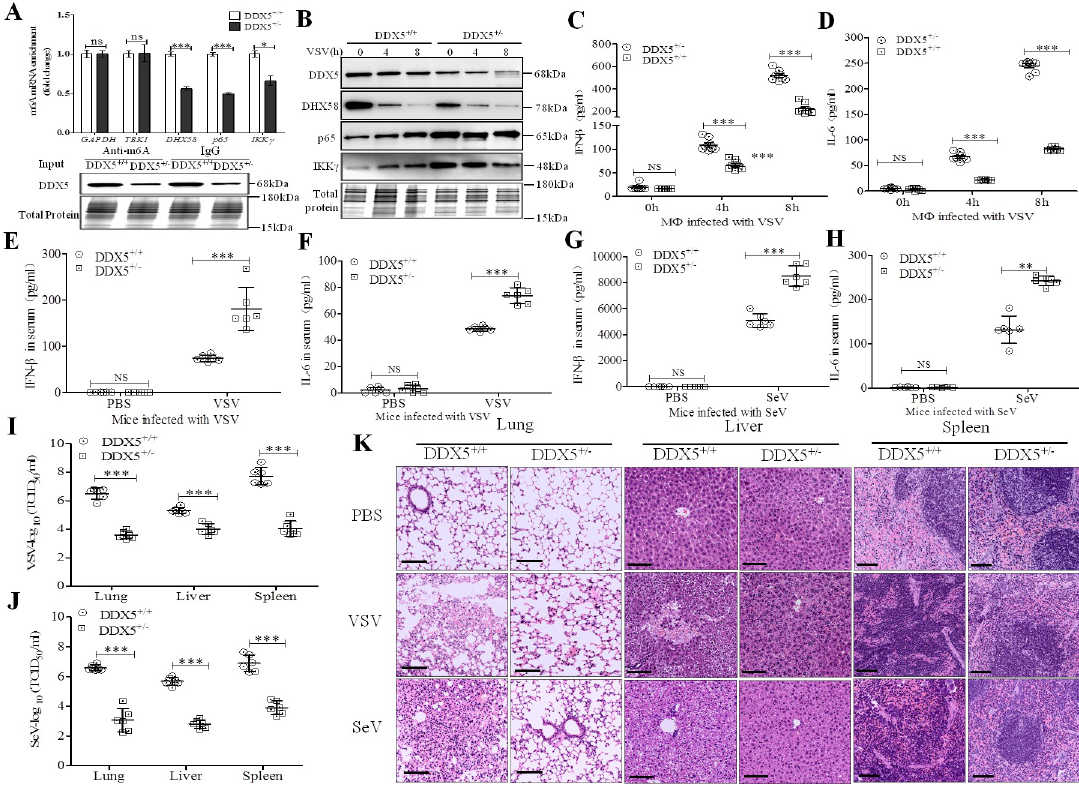
Fig 8. DDX5 negatively regulates innate immunity in vivo. (A): m6A methylation of transcripts was detected in DDX5 +/+ or DDX5 +/- primary mouse macrophages infected for 8 h with VSV (MOI = 10). After extracting total RNA and purifying mRNA, mRNA was used to perform m6A qRT-PCR by incubating with anti-rabbit m6A or anti-rabbit IgG-conjugated dynabeads for 4 h. RNA was isolated and subjected to qRT-PCR using GAPDH, TBK1, DHX58, IKK γ , and p65 primers. Results are presented relative to those obtained in the control group, and the expression of DDX5 was analyzed bywestern blotting. (B): Immunoblot analysis of DDX5, DHX58, p65, and IKK γ in lysates of DDX5 +/+ or DDX5 +/- mouse macrophages infected for 0, 4, and 8 h with VSV (MOI = 10). (C, D): ELISA of IFN- β (C) and IL-6 (D) in cell supernatants ofDDX5 +/+ or DDX5 +/- mouse macrophages infected for 0, 4, and 8 h with VSV (MOI = 10). (E, F): ELISA of IFN- β (E) and IL-6 (F) in serum after DDX5 +/+ or DDX5 +/- mice were intraperitoneally injected with PBS or VSV (5 × 10 8 plaque-forming units/g body weight) for 8h (n = 6). (G, H): ELISA of IFN- β (G) and IL-6 (H) in serum after DDX5 +/+ or DDX5 +/- mice were intraperitoneally injected with PBS or SeV (1 × 10 8 plaque-forming units/g body weight) for 8h (n = 6). (I, J): The TCID 50 dose of VSV (I) or SeV (J) was measured in lungs, liver, and spleen of DDX5 +/+ or DDX5 +/- mice. (K): Pathological lesions in lungs, liver, and spleen of DDX5 +/+ or DDX5 +/- mice observed by hematoxylin-eosin staining with intraperitoneal injection of PBS, VSV (5 × 10 8 plaque-forming units/g body weight) or SeV (1 × 10 8 plaque-forming units/g body weight) for 12h. Scale bars, 100 μ m. All data are presented as mean ± SEM of biologically independent samples. n = number of biological replicates. Data are representative of three independent experiments. NS, no significant difference. �� p < 0.01, ��� p < 0.001 (Student’s t